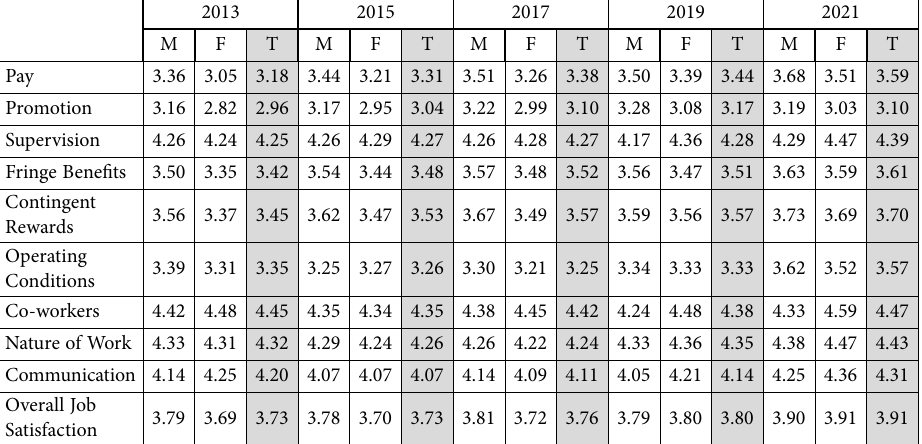
Table 2. Job Satisfaction level since 2013 (T – overall job satisfaction, M – males, F – females) (source: own